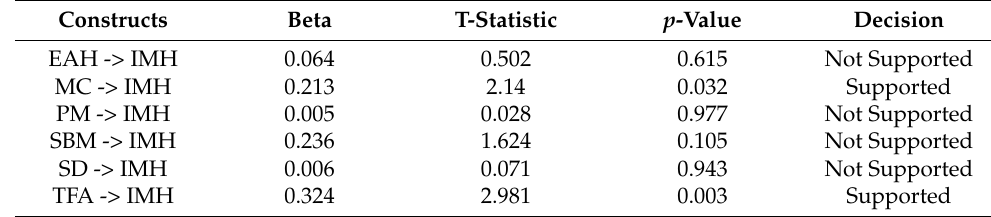
Table 4. Beta value, t-statistic, p -value, and hypothesis